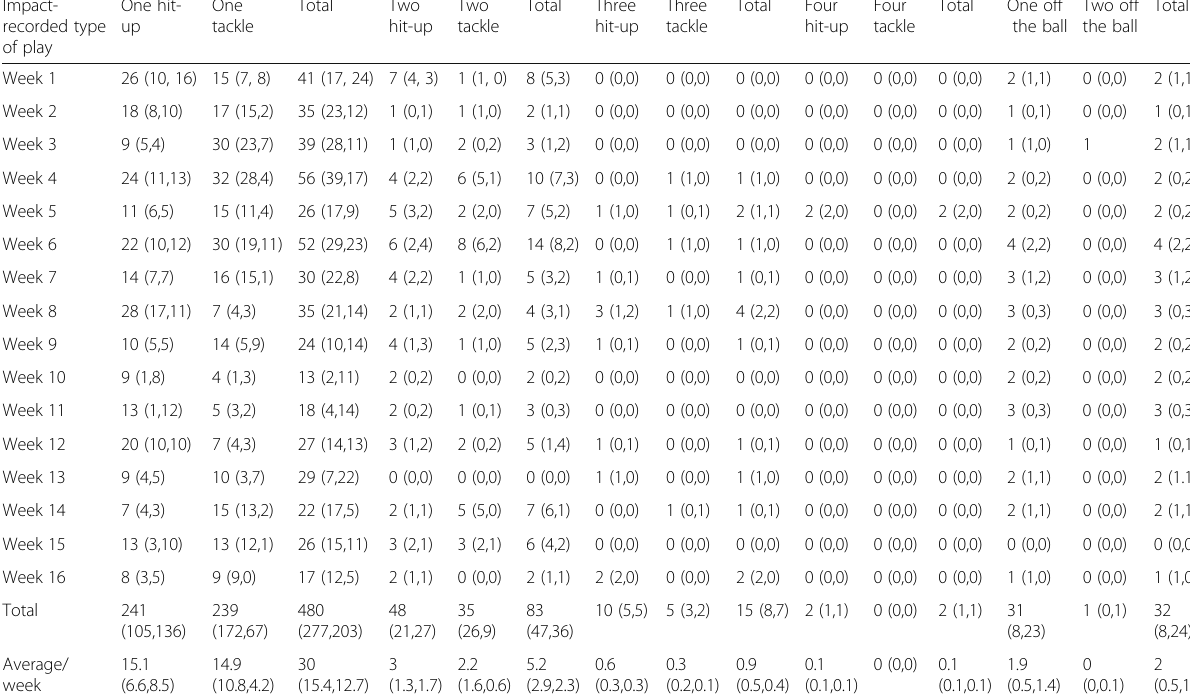
Table 4 Total x-patch ™ -recorded impacts per play Impact- recorded type